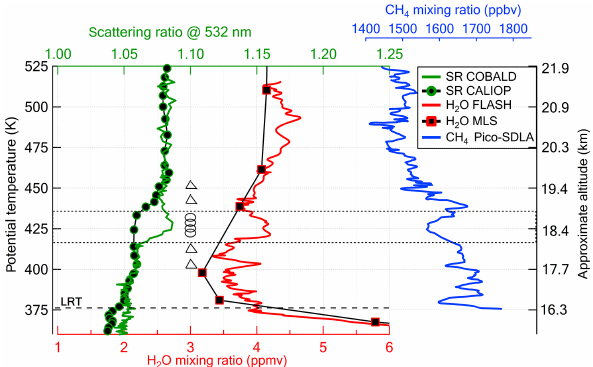
Figure 1. Vertical profiles of scattering ratio from COBALD (solid green, 13 March) and CALIPSO (green/black circles, February zonal mean), water vapour from FLASH-B (solid red, 13 March) and MLS (red/black squares, 13 March), methane (solid blue, Pico- SDLA on 14 March). Horizontal dotted lines mark the lower and up- per boundaries of the water/aerosol-enriched and methane-depleted layer. Horizontal dashed line marks the lapse rate tropopause (LRT) level. The circles and triangles indicate the altitude levels, from where CLaMS back trajectories were initialised (same convention for the markers is used in Fig. 2). See text for detail.